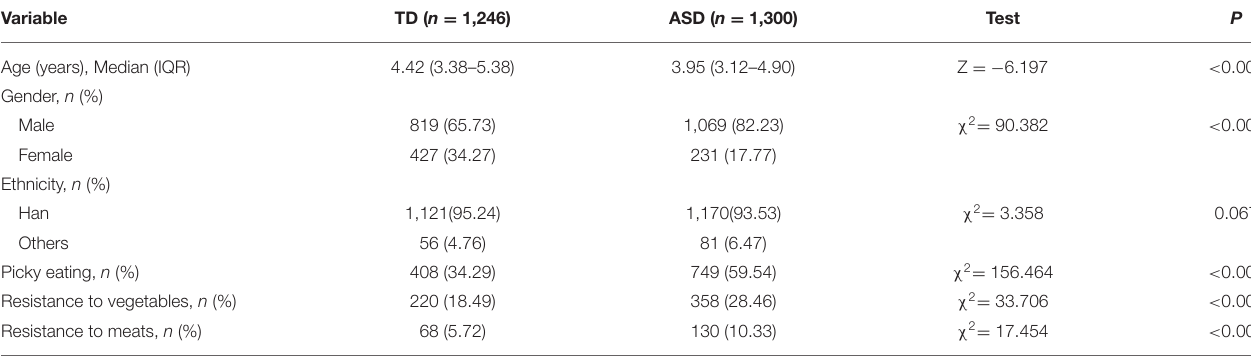
TABLE 1 | Comparison of demographic characteristics between TD and ASD children.